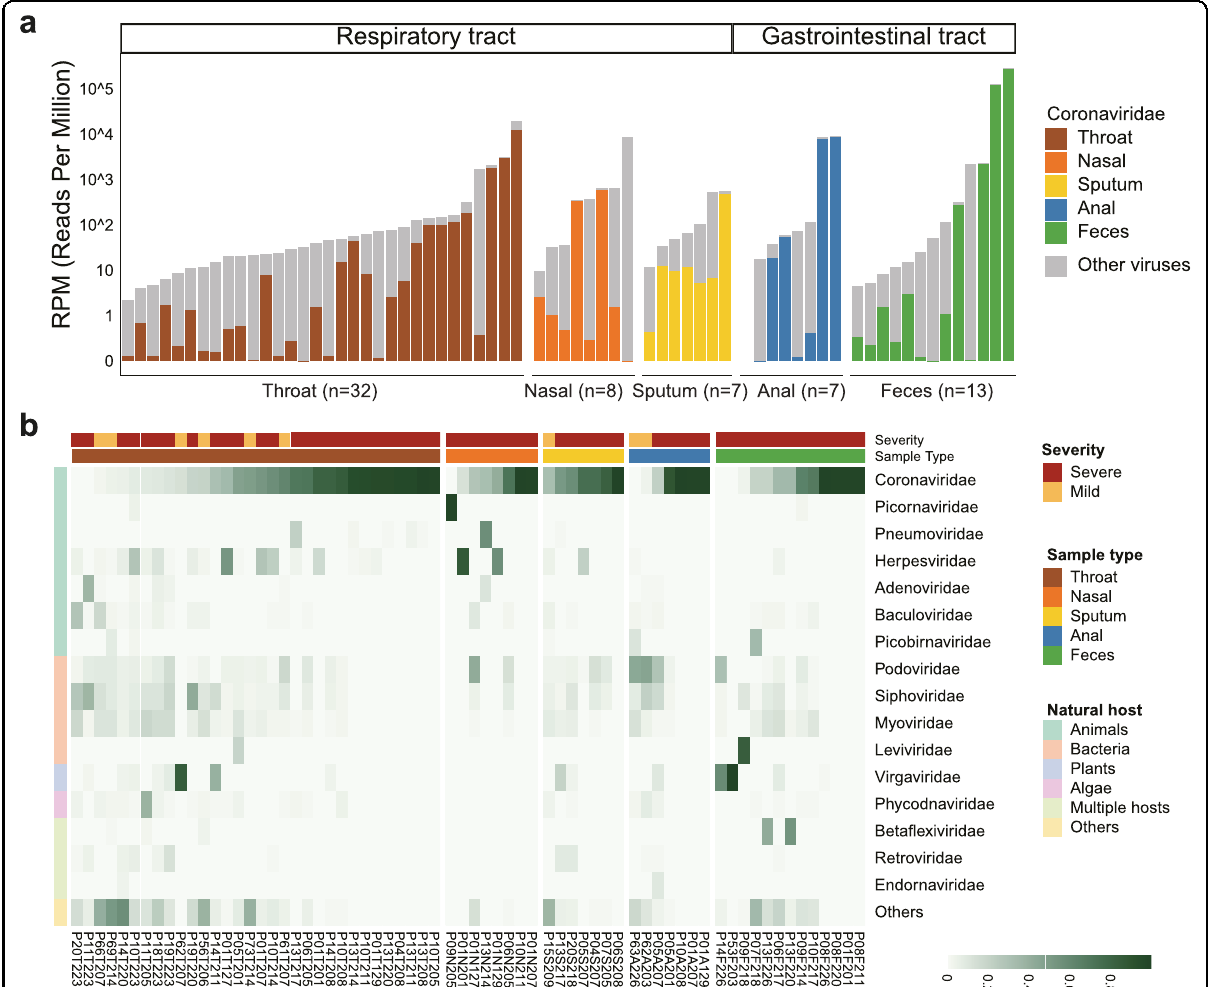
Fig. 1 Viral RNA pro fi les in clinical specimens of hospitalized patients with COVID-19. a Bar plot showing the number of total viral reads and Coronaviridae reads in 67 clinical specimens collected from the respiratory and gastrointestinal tract. Data have been normalized to total sequencing reads in reads-per-million (RPM). The Coronaviridae reads of different sample types are colored as follows: brown, throat swab; orange, nasal swab; yellow, sputum; blue, anal swab; green, feces. Gray, non-Coronaviridae viral reads. b Heatmap showing the viral RNA relative abundance at the family level. Top 16 viral families are shown and ranked according to their natural hosts: green, animals; pink, bacteria; light blue, plant; purple, algae; light green, multiple host species; yellow, others (viral families of low abundances). Specimens from patients with mild and severe COVID-19 symptoms are colored by brick red and orange,